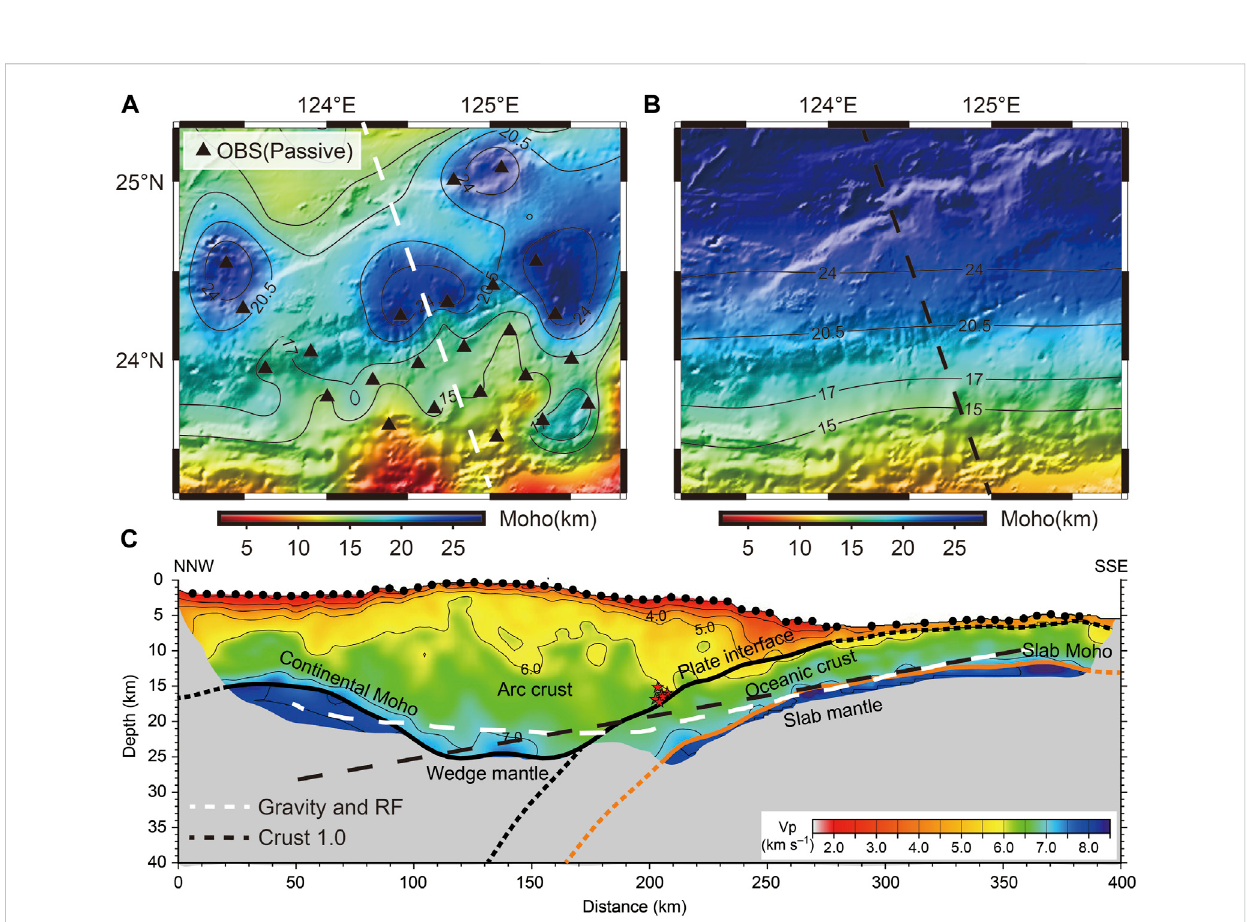
FIGURE 11 (A) Moho depth calculated by gravity inversion constrained by receiver function in the Ryukyu Trench. (B) Distribution map of crustal thickness with CRUST1.0model(Laskeetal.,2012). (C) Seismicre fl ectionpro fi leofactivesourceline[Araietal.(2016),modi fi ed][ThewhitedottedlinerepresentsMoho depth obtained by gravity inversion constrained by receiver function; The black dotted line represents Moho depth from CRUST1.0 (Laske et al.,